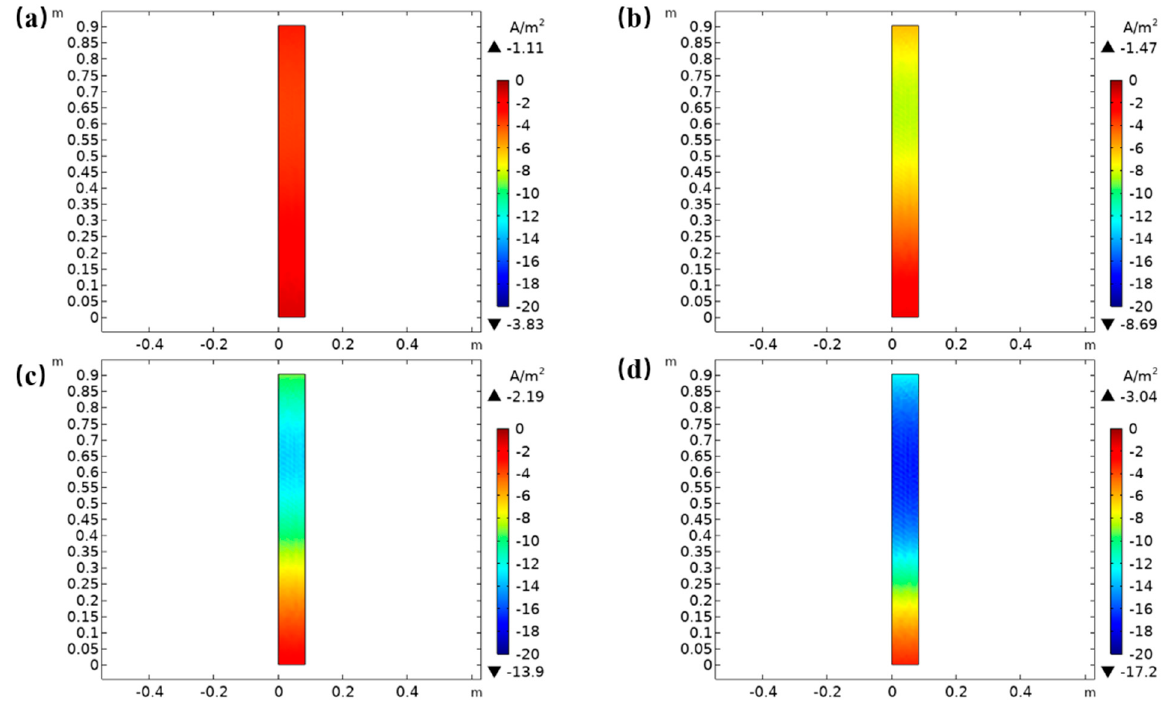
Figure 10. Difference in current density of the negative diaphragm side intercalation at the charging cutoff moment for different operating conditions at 25 ◦ C. ( a ) 0.5 C; ( b ) 1 C; ( c ) 1.5 C; ( d ) 2 C. In summary, electrode SOC differences and current density differences combine to cause temperature inhomogeneity, due to the distribution of large-size cell lugs. Electrode SOC and current density inhomogeneity characteristics can be introduced from the temperature inhomogeneity distribution, while electrode SOC and current density differences indicate the physical mechanism of the temperature inhomogeneity.